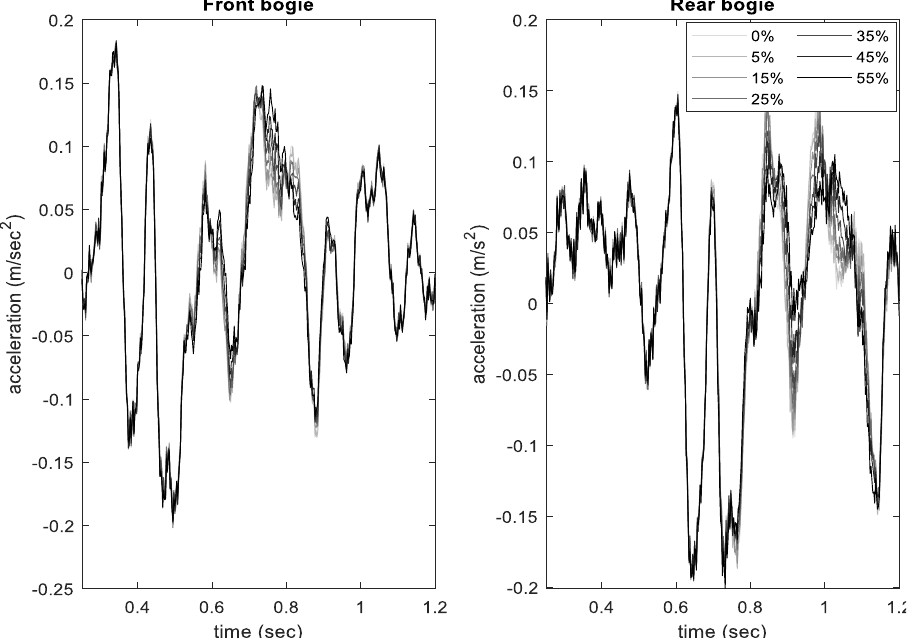
Figure 3. A sample of acceleration signals for front (1st) and rear (2nd) bogies for different damage levels at mid-span at the speed of 105 kph.